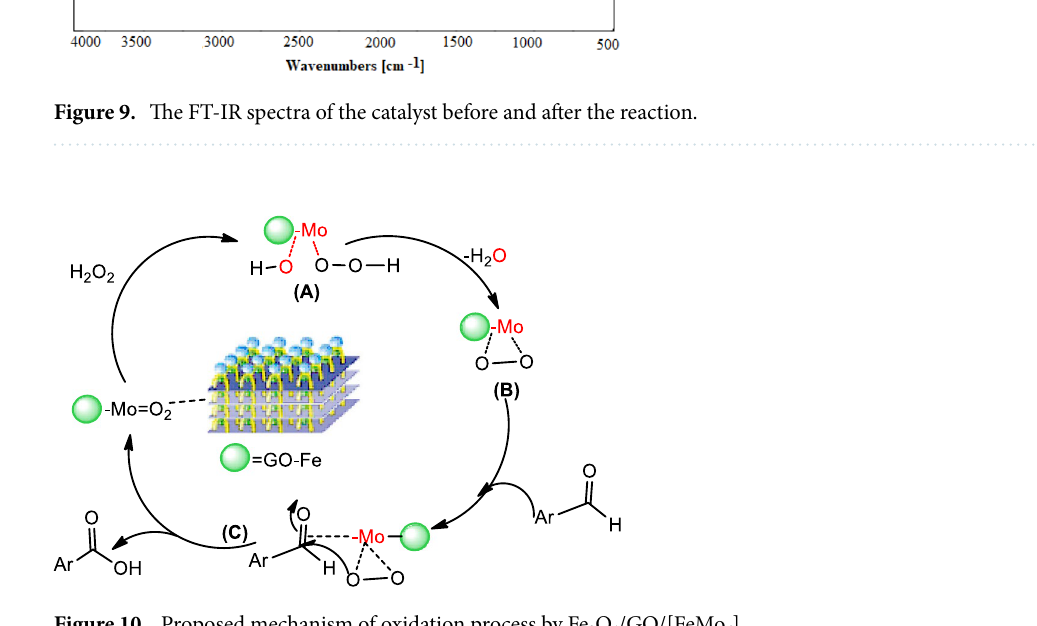
Figure 10. Proposed mechanism of oxidation process by Fe 3 O 4 /GO/[FeMo 6